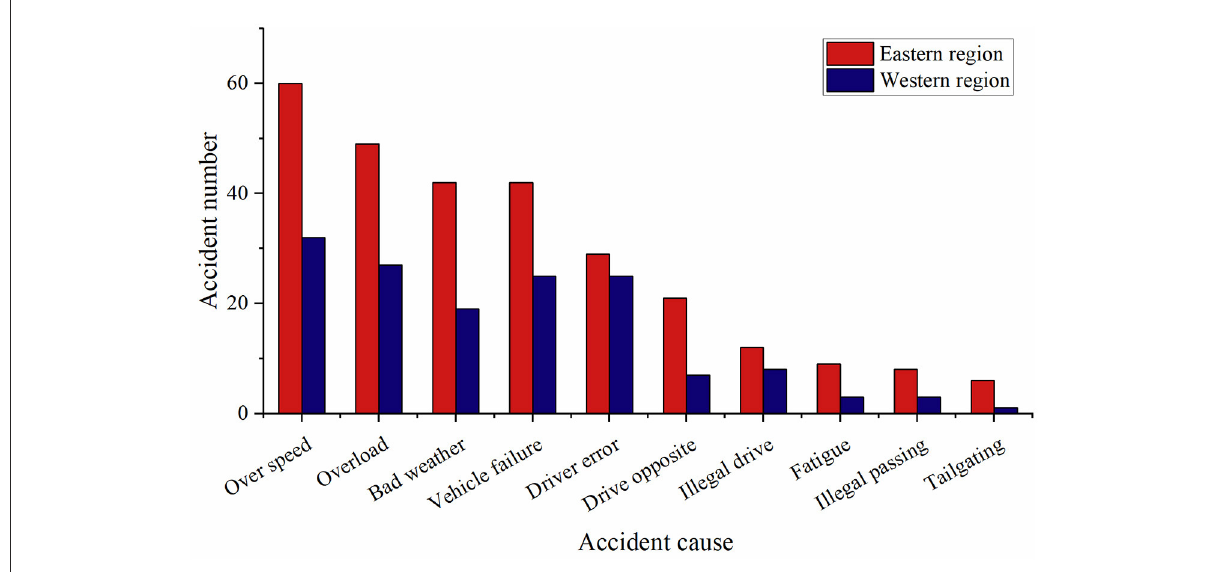
FIGURE7 Distribution of reasons for extremely serious traffic accidents in the eastern and western